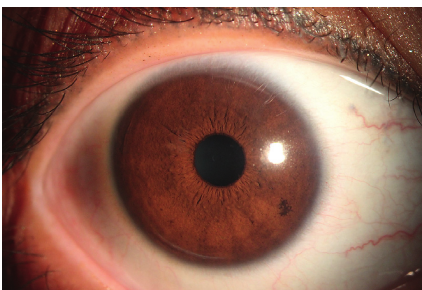
Figure 2: The location of the cornea limbal relaxing incision in the LenSx +ICL group after surgery (the red arrow in the Figure shows the location of limbal relaxing